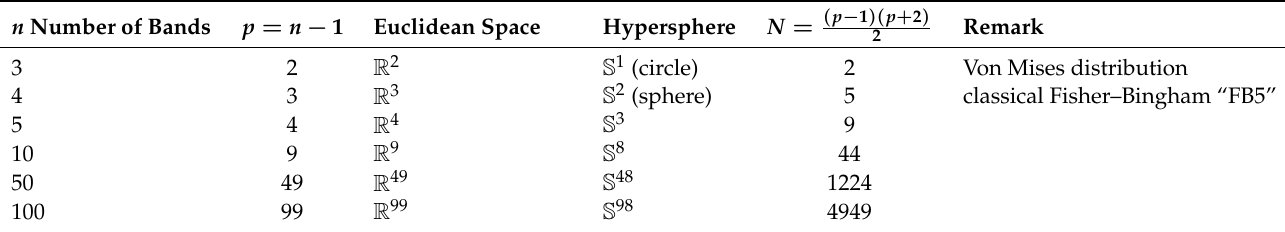
Table A1 below summarizes the number of parameters of the FBK distribution de- pending on the number of bands ( n ) or dimension of the corresponding Euclidean space